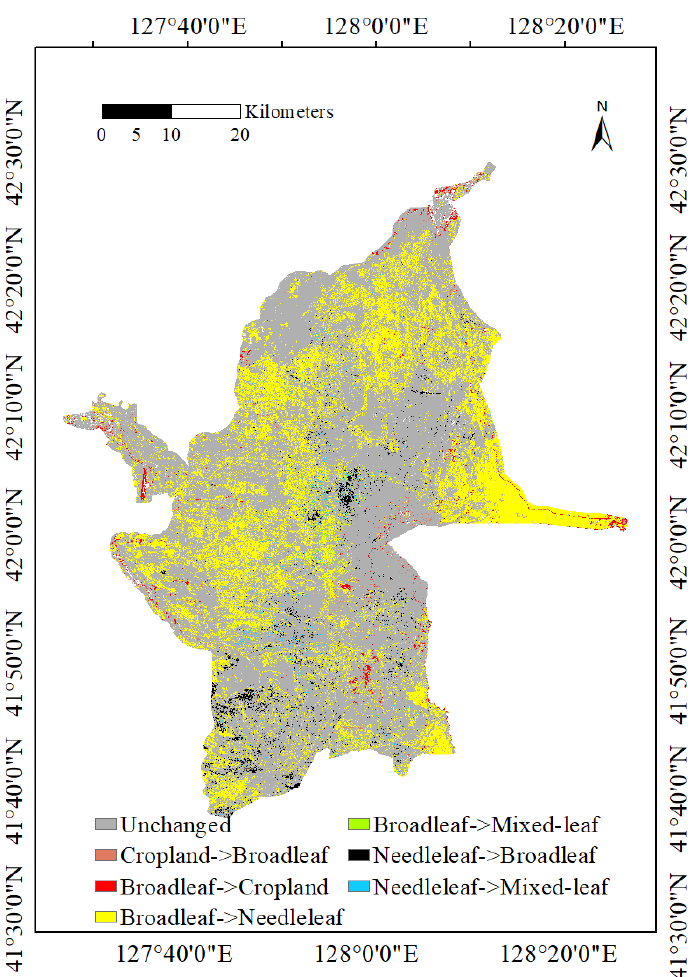
Figure 4. Major changes in land cover types of Changbai Mountain Reserve from 1995 to 2020.